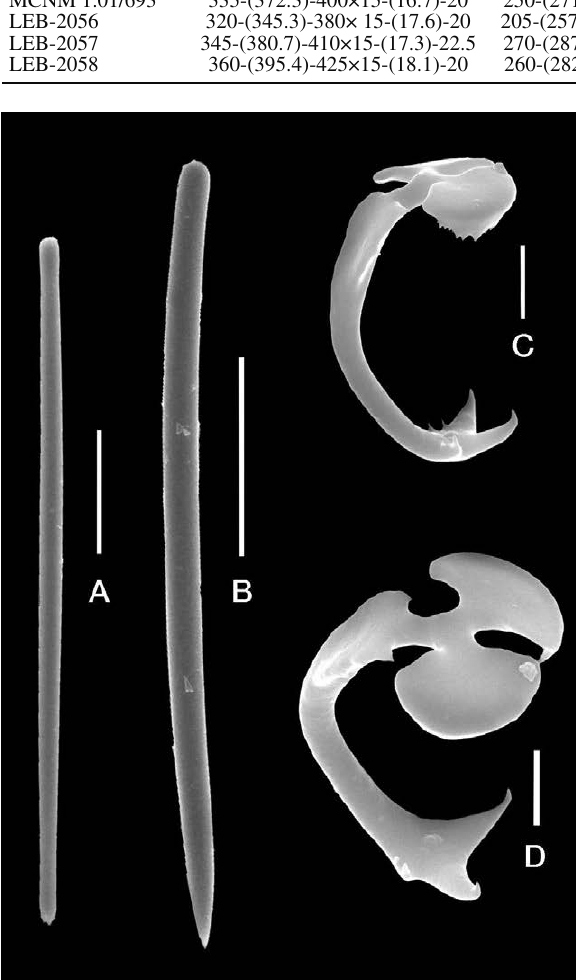
Fig . 13. – Iophon bipocillum n. sp. A, Ectosomal tylote with micro- spined heads. B, Choanosomal style. C, Bipocillae lateral view. D, Bipocillae view of the upper part. Scale: A, 40 μm; B, 70 μm; C, 3.5 μm; D, 3